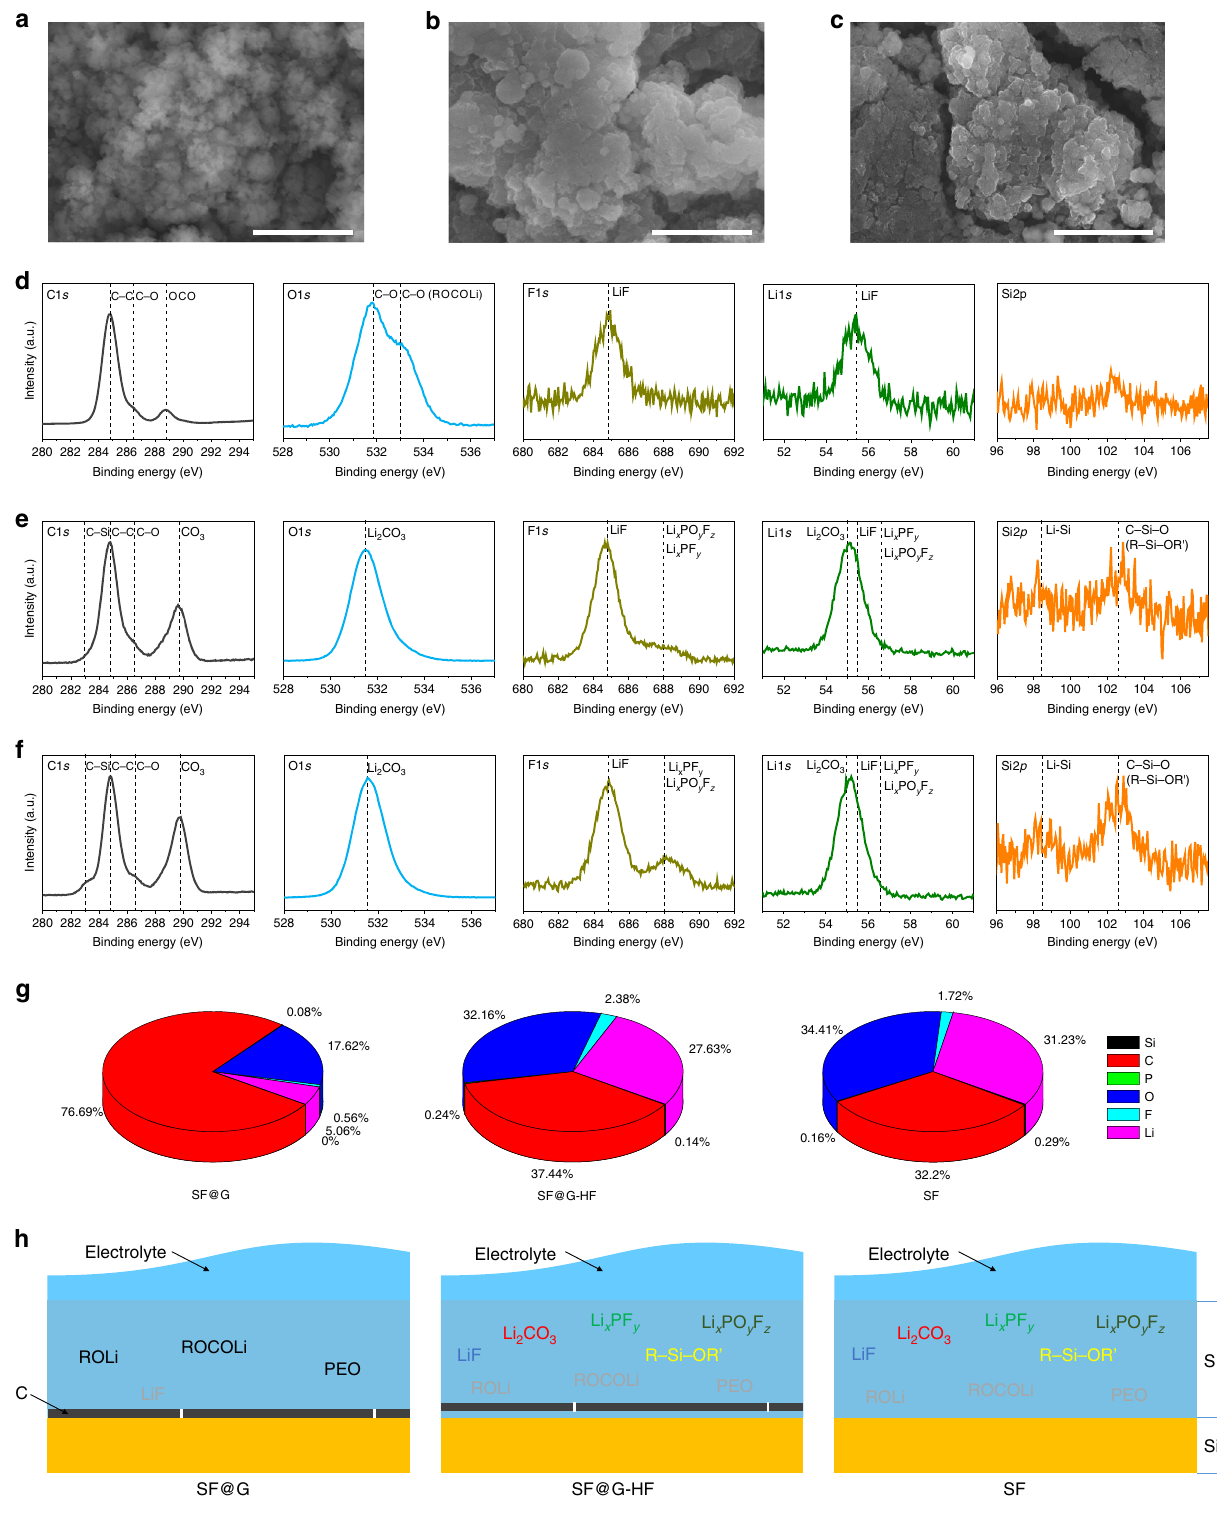
Fig. 5 Interfacial morphology and chemical composition after cycling. a – c SEM images of ( a ) SF@G, ( b ) SF@G-HF, and ( c ) SF after 100 cycles. d – f C 1 s , O 1 s , F 1 s , Li 1 s , and Si 2 p XPS spectra of ( d ) cycled SF@G, ( e ) cycled SF@G-HF, and ( f ) cycled SF. g Interfacial atom concentrations of cycled SF@G, SF@G- HF, and SF. h Schematic description of the interface of cycled SF@G, SF@G-HF, and SF, showing distinctly different components as the majority of cycled SF@G and control samples. It is noteworthy that the components annotated in gray represent the minority and the SEI thickness is not scaled. Scale bars, 2 µ m ( a – c